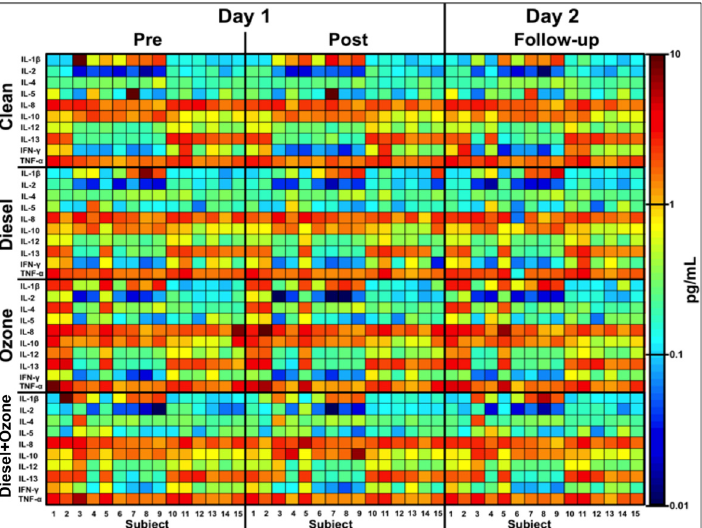
Fig 2. Heatmap of the plasma cytokine levels for all exposure treatments over a 24-hour period. The concentrations in Fig 2 increase as the color changes from blue to red.